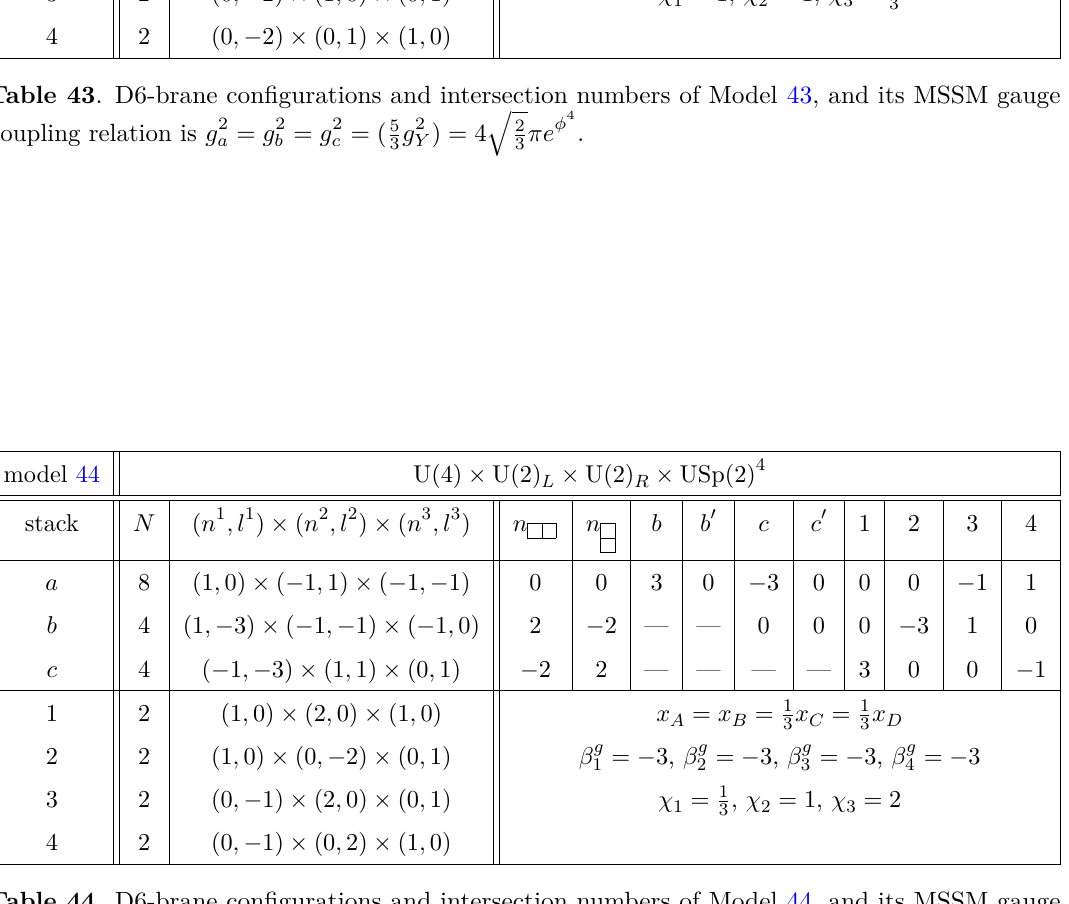
Table 44 . D6-brane configurations and intersection numbers of Model 44, and its MSSM